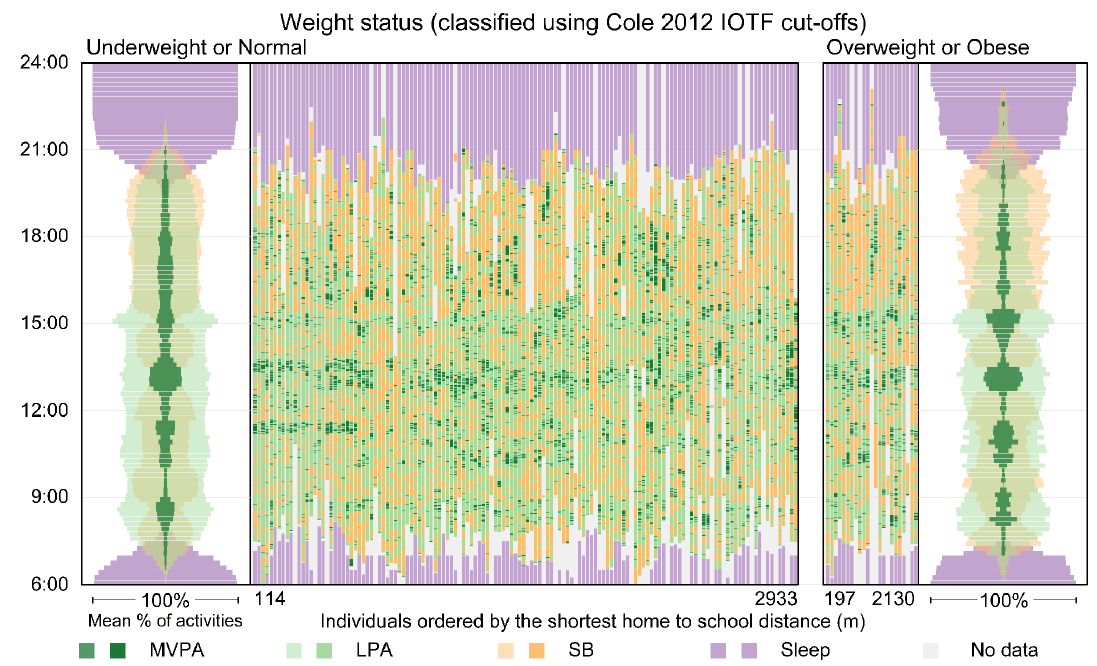
Figure 5. Time–Activity diagram showing individual and aggregated patterns using data for Wednesdays and/or Thursdays for boys in the least deprived areas who actively travelled to school. The diagram is configured as 2 main panels with boys who were classified as underweight or normal on the left and boys who were classified as overweight or obese on the right. The vertical dimension shows time of day. Individual-level time-use patterns for the 4 activity types for the two groups are shown in the middle of the diagram. Each vertical timeline represents one boy’s sequential daily activities from 6:00 to midnight, with the light grey colour indicating missing information. The boys’ timelines are ordered within each panel by travel distance from home to school in meters. Note that an active travel classification indicates the regular travel mode. It does not guarantee that the child actually travelled to school actively on the two days displayed here. Travel distances greater than 3000 m were removed.